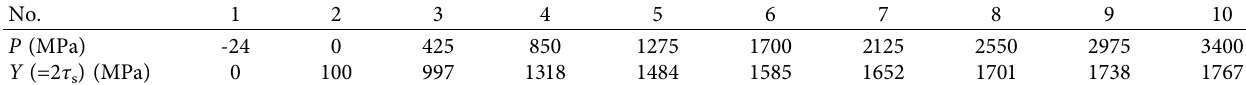
Table 5: Inputted strength data of Wulian granite based on the Lundborg criterion.